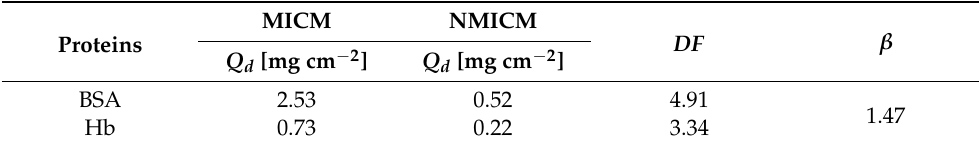
Figure 10. The dynamic adsorption curves of MICM and NMICM in the BSA/BHb mixed solution. Table 7. The dynamic adsorption performance of MICM and NMICM in the BSA/BHb mixed so- Table 7. The dynamic adsorption performance of MICM and NMICM in the BSA/BHb lution. mixed